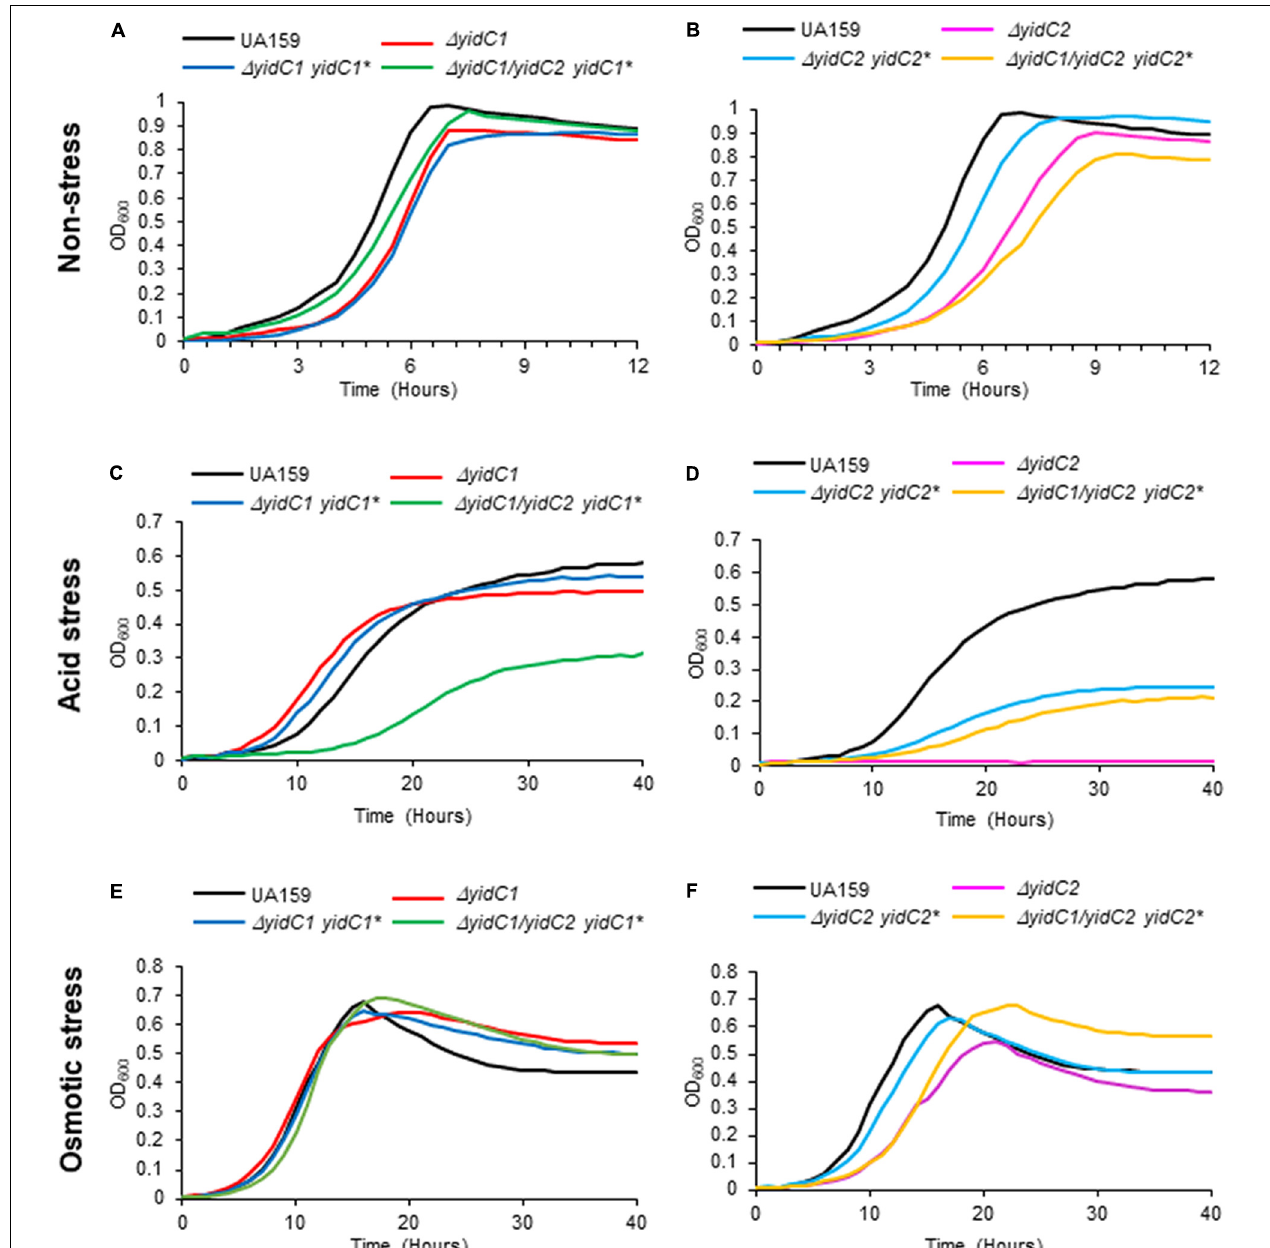
FIGURE 3 | Evaluation of growth of S. mutans wild-type, D yidC1 / 2 mutants, and ectopic expression strains under non-stress, acid-stress, and salt-stress conditions. Growth of the wild-type UA159 parent strain compared to (cid:49) yidC1 (A,C,E) or (cid:49) yidC2 (B,D,F) deletion mutants, and strains complemented by ectopic expression (*) from the gtfA locus of yidC1 or yidC2 in single (cid:49) yidC1/2 or double (cid:49) yidC1/ (cid:49) yidC2 backgrounds. (A,B) Growth in THYE, pH 7). (C,D) Growth in THYE acidified to pH 5.0. (E,F) Growth in THYE supplemented with 3% NaCl. Growth measurements were carried out at least three times with each sample assayed in triplicate. Data shown are mean replicates of an independent